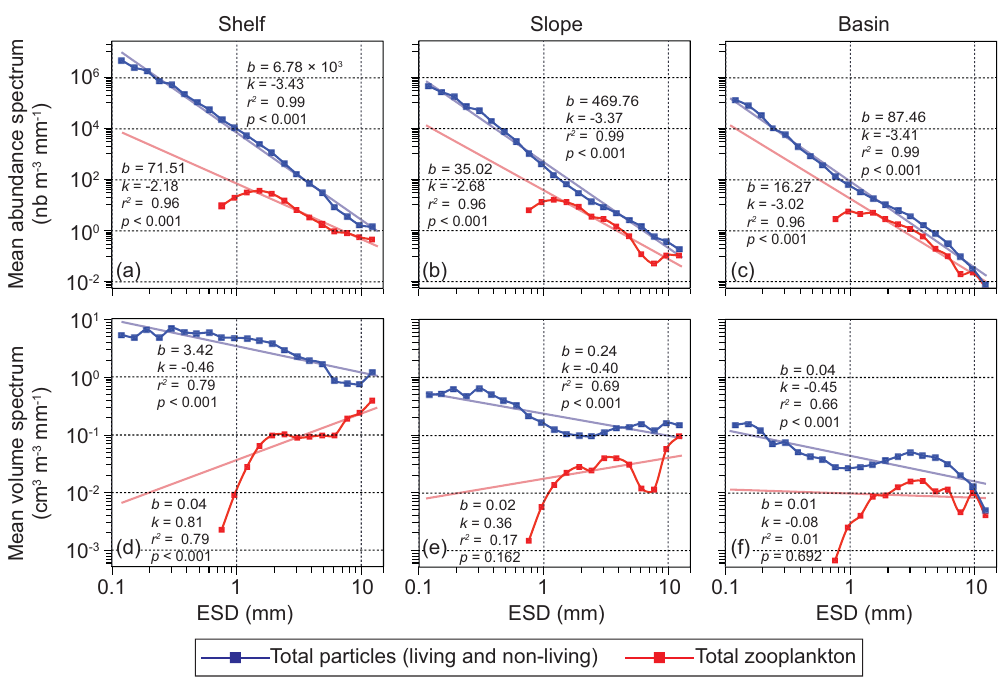
Fig. 3. Mean size spectra of abundance (a–c) and volume (d–f) of total particles and total zooplankton as measured with the Underwater Vision Profiler deployed across the shelf ( < 100m), slope (100–1000m), and basin ( > 1000m) regions of southeast Beaufort Sea in July– August 2009 (Fig. 1). The b and k values correspond, respectively, to the constants and scaling exponents (slopes in a log-log form) of the power-law equations ( n = bd k ) derived from the normalized particle size distributions (see Sect. 2.2 for details). The power-law relationships for total particles were calculated using the full range of 0.1–12mm (expressed in equivalent spherical diameter, ESD), whereas the equations for zooplankton were calculated using only the organisms > 1mm ESD because of the loss in the efficiency of detection in the low end ( ≤ 1mm ESD) of the zooplankton size spectrum. The percent contributions of living particles to total particles as estimated with the idealized power-law equations are presented in Fig.